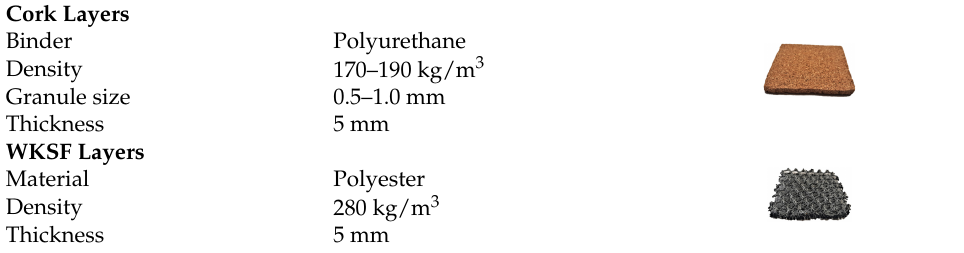
Figure 2. Multi ‐ layer composite configurations.